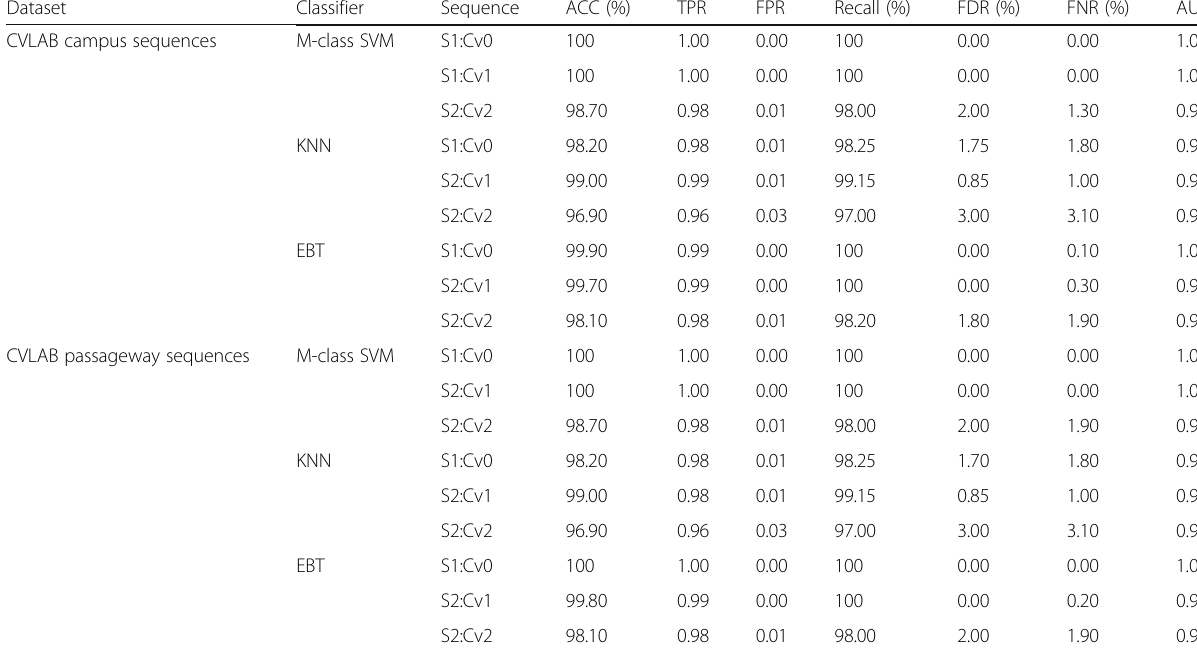
Table 1 Proposed algorithm results using EPFL dataset